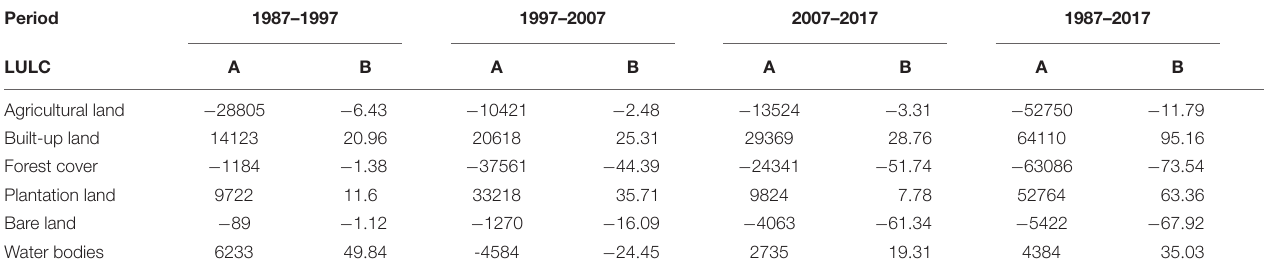
TABLE 1 | LULC change in Barddhaman district (1987–2017).